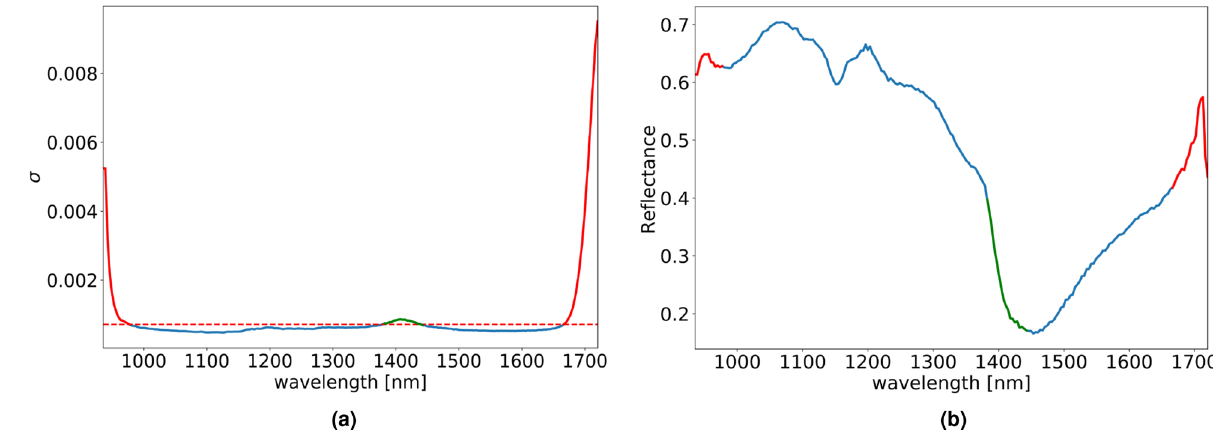
Figure 5. ( a ) Estimated σ through spectral bands with a dashed red line denoting the adopted threshold for selection of relevant spectral bands. σ s values are colored blue/red color to specify if the corresponding spectral bands are kept or disregarded from further analysis. The spectral bands which correspond to the σ s colored in green are kept since they provide useful information for sepal segmentation ( b ) Spectral response of a pixel belonging to a sepal marked with blue, red and green colors for correspondence with the estimated σ s in the graph on the